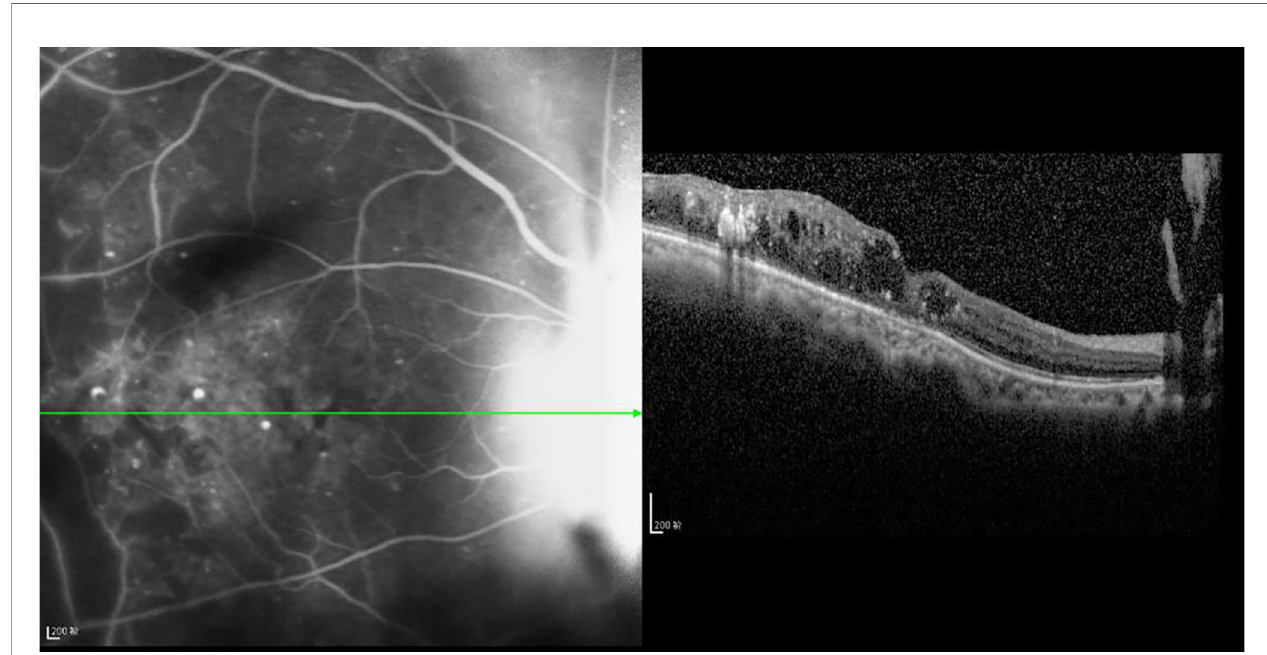
FIGURE 9 | The CFT value is 352 m m, the fracture distance of the ELM and IS/OS layers is >2,000 m m, and there is mixed retinal edema. R 2